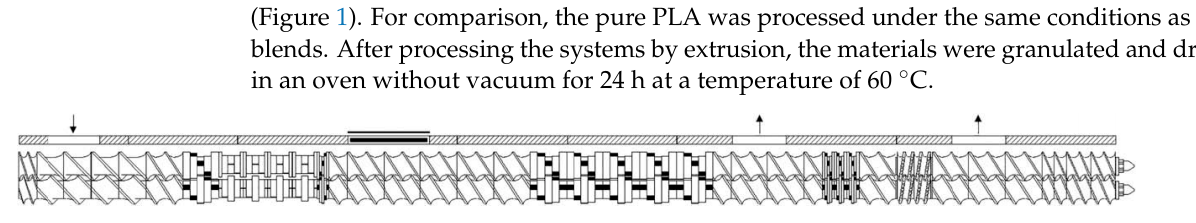
Figure 1. Extruder screw profile used with distributive and dispersive mixing elements [22] .